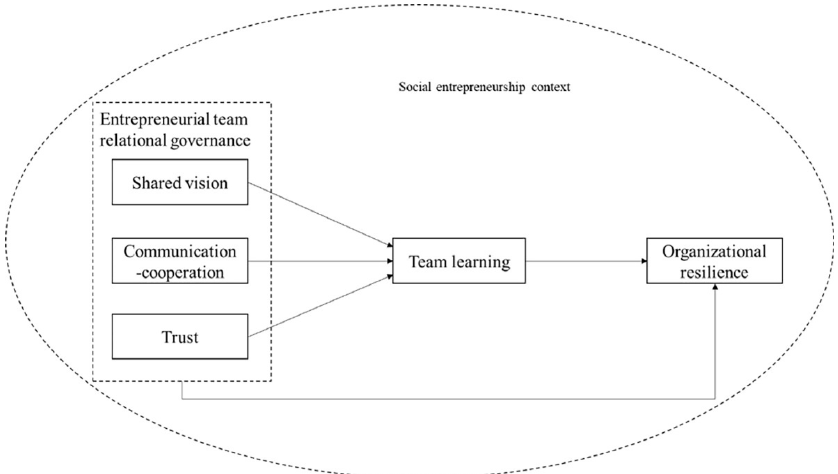
Figure 1. Theoretical Framework Design.